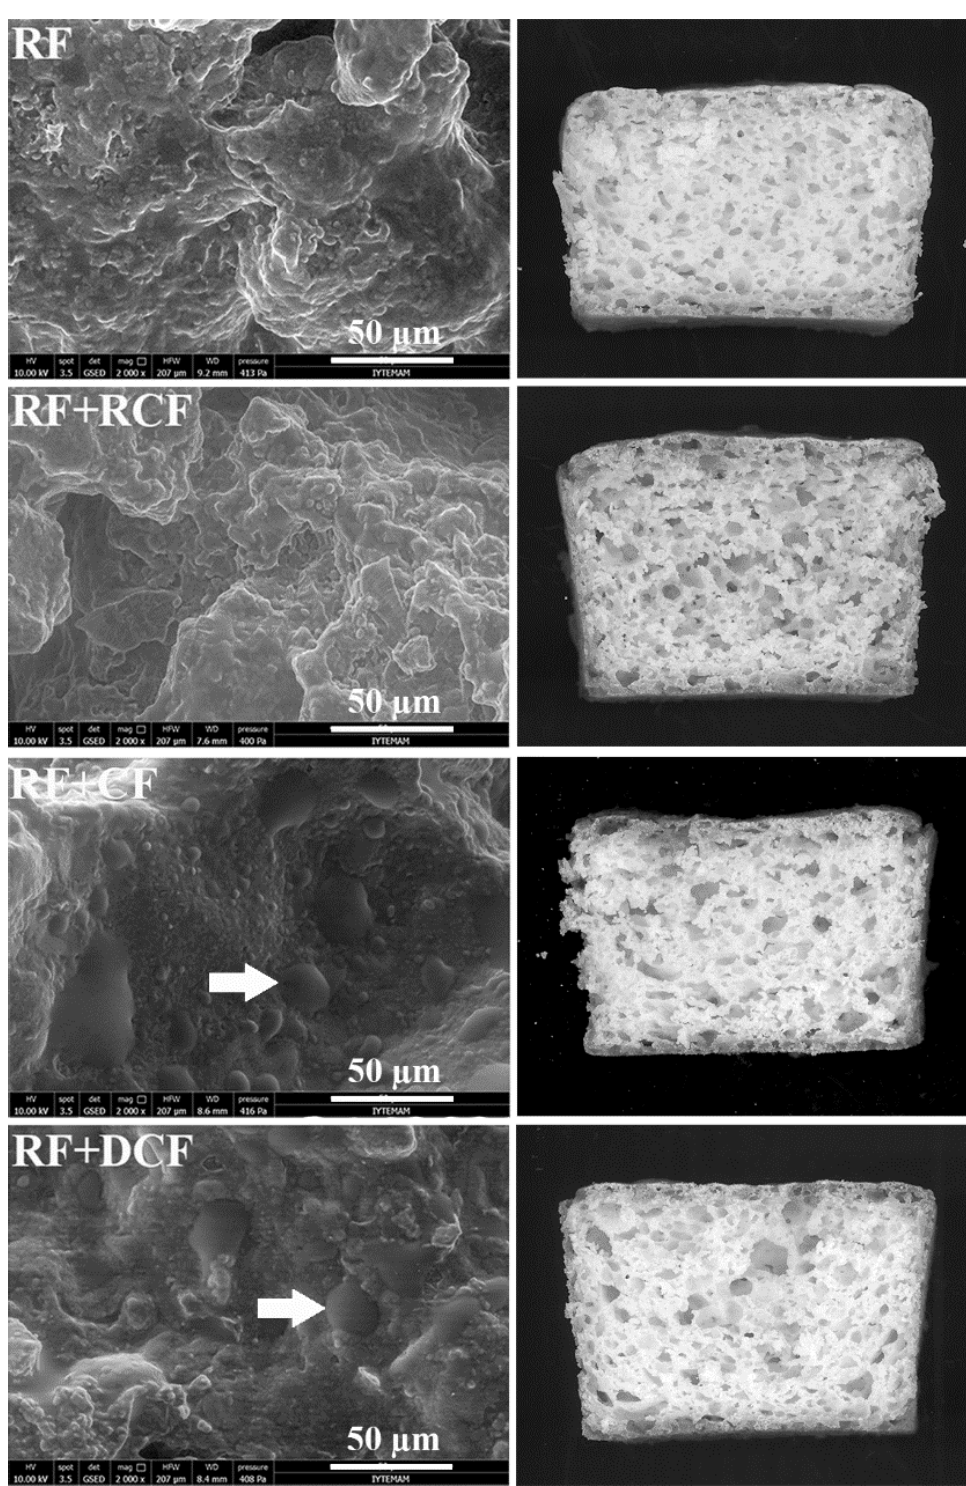
Figure 1. Crumb microstructure (Magnification ×2000) and cross-section of gluten-free bread (RF, rice flour; RCF, roasted chickpea flour; CF, raw chickpea flour; DCF, dehulled chickpea flour). The starch granules are shown with a white arrow.